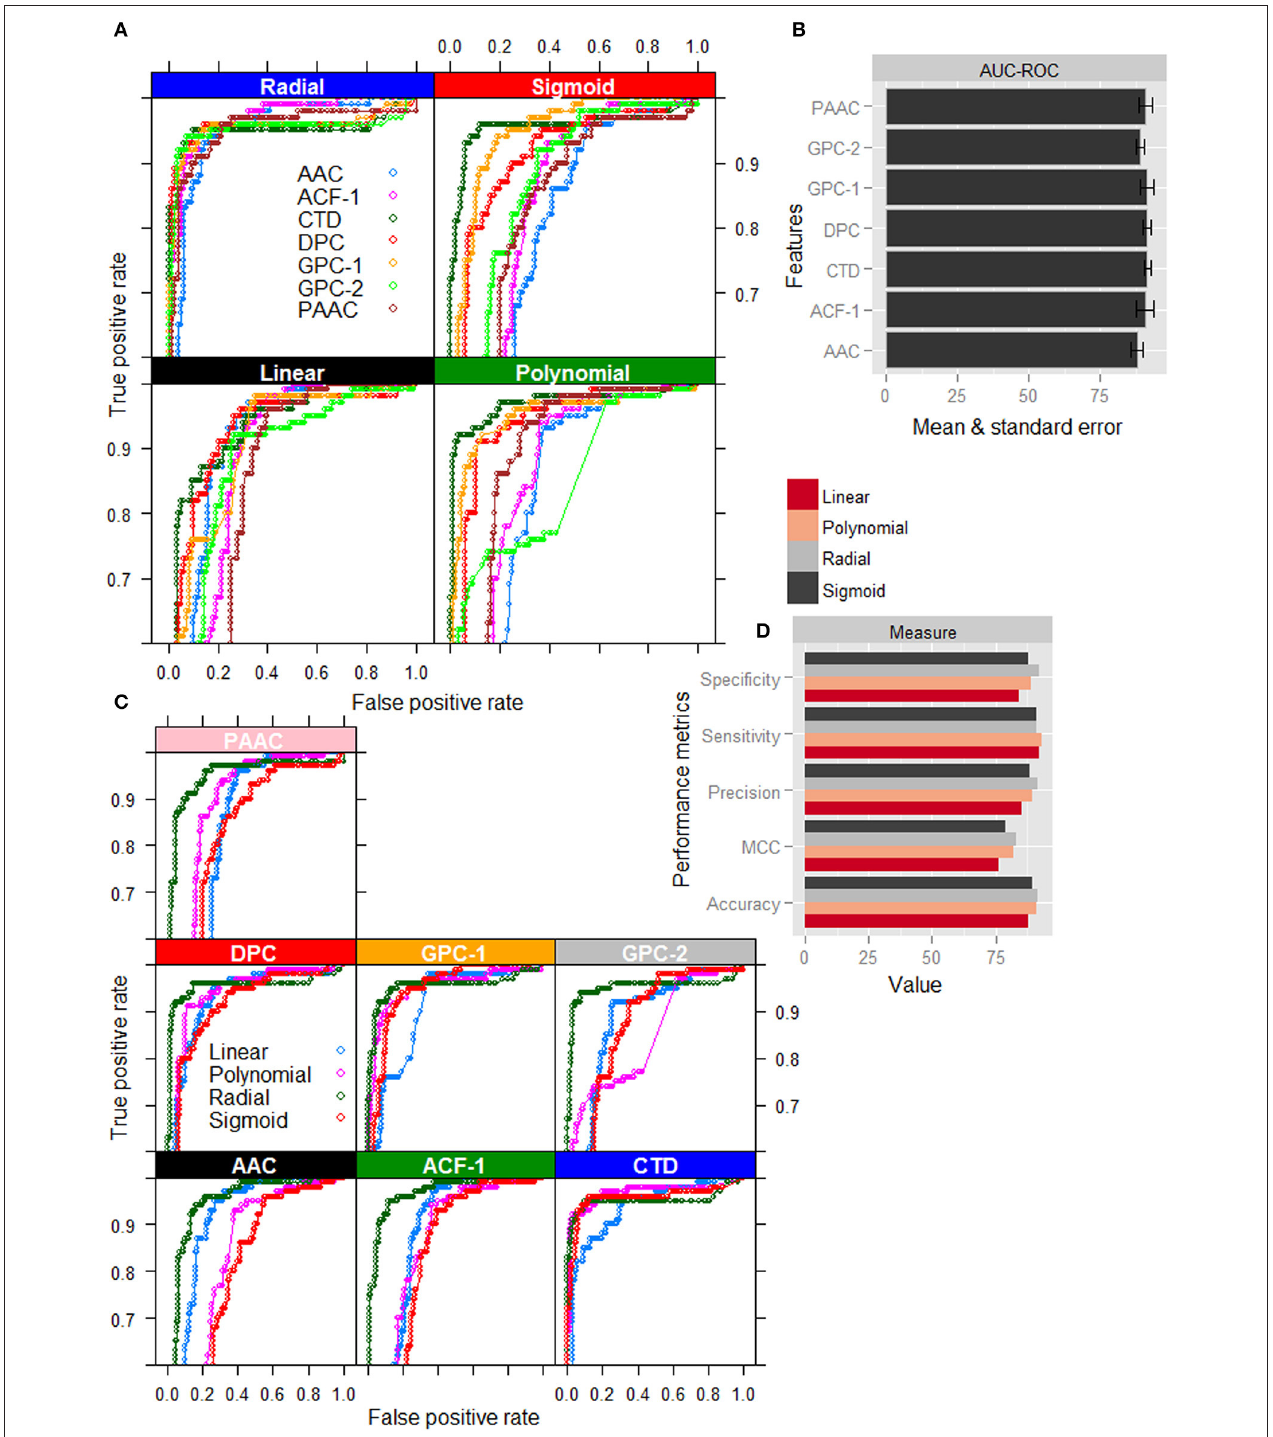
FIGURE 2 | Graphical representation of performance metrics for different feature-kernel combinations. (A) ROC curves of four different kernels of SVM for classification of nitrogen-fixation (nif) and non-nitrogen-fixation (non-nif) proteins with seven different feature sets. (B) Bar plots of AUC-ROC for radial kernel of SVM with different combination of features. (C) ROC curves for different feature sets with respect to classification of nif and non-nif proteins using four different kernels of SVM. (D) Bar plots of performance metrics for four different kernels with CTD feature set. The figures show that the combination of radial kernel and CTD feature set is better than the other feature-kernel combinations for classification of nif and non-nif